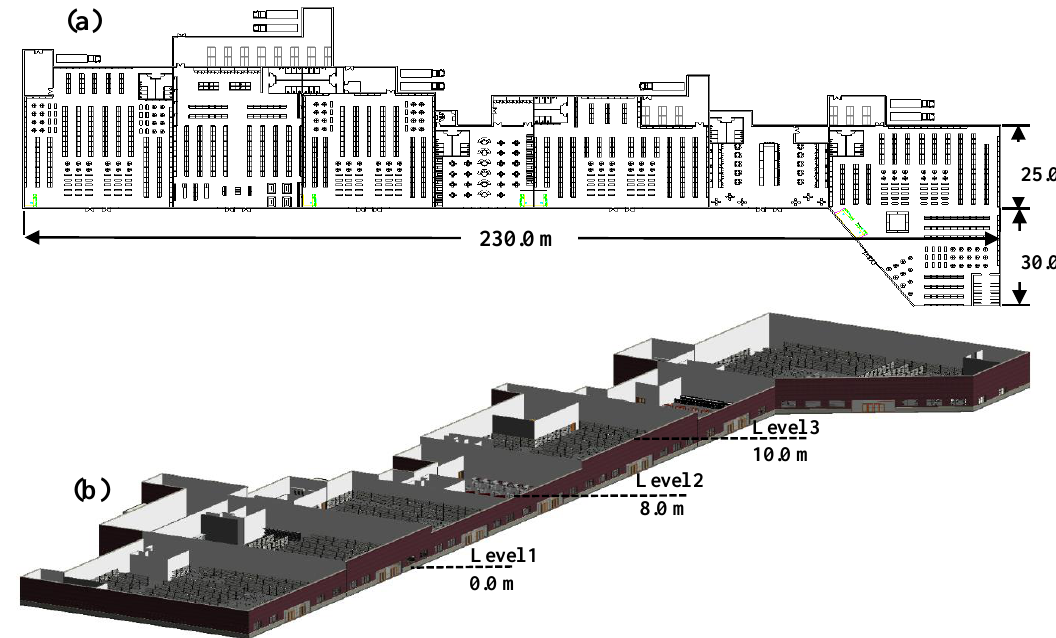
Figure A6. F6 archetype plans and views: ( a ) Plan view; ( b ) 3-D view.